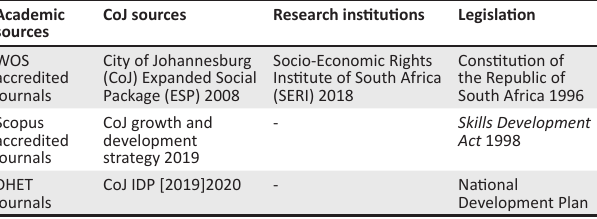
TABLE 1: Secondary data